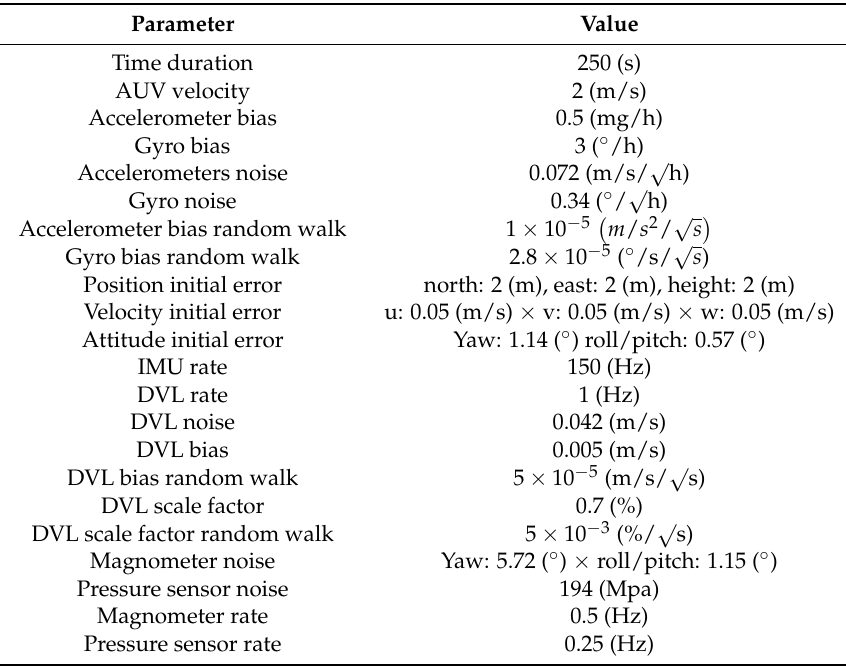
Table 2. TAUV 6DOF simulation and navigation